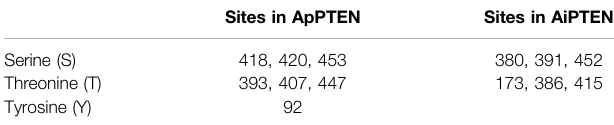
TABLE 2 | The speci fi c phosphorylation sites in ApPTEN and AiPTEN. Sites in